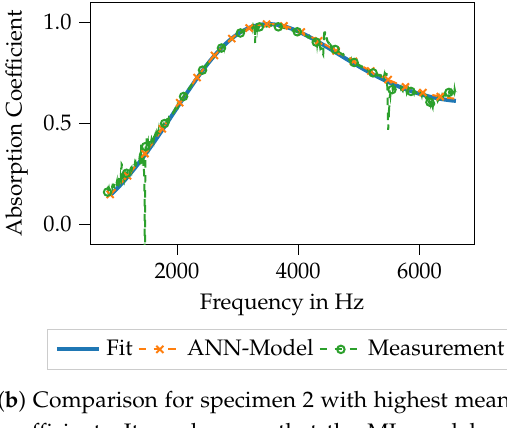
( a ) Comparison for specimen 39 with lowest mean absorption ( b ) Comparison for specimen 2 with highest mean absorption coefficient. It can be seen that the ML model resembles the coefficient. It can be seen that the ML model resembles the inversely identified parameters nearly perfectly, and both fit the inversely identified parameters nearly perfectly, and both fit the measurement to a high extend. measurement to a high extend. Figure 12. Comparison of the measured absorption coefficient, the absorption coefficient computed from the inversely iden- tified Biot parameters (’Fit’) and absorption coefficient computed using the Biot parameters outputted by the ANN